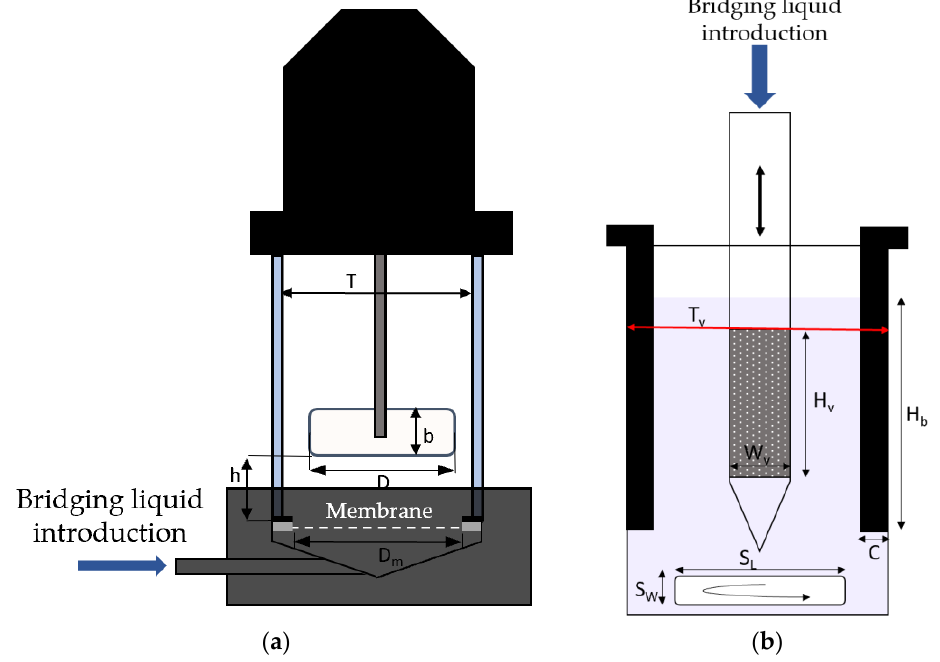
Figure 1. Schematic of ( a ) Dispersion cell with a flat-blade impeller above a flat-disc membrane, with dimensions: D m = 3.45 cm, T = 3.75 cm, D = 2.95 cm, b = 1.2 cm, h = 0.5 cm, n b = 2, V b = 4.33 mL; ( b ) Vibrating membrane module with dimensions: W v = 1.3 cm, H v = 6.5 cm, T v = 4.3 cm, H b = 3.75 cm, c =0.7 cm, S W = 1.05 cm, S L = 3.8 cm.